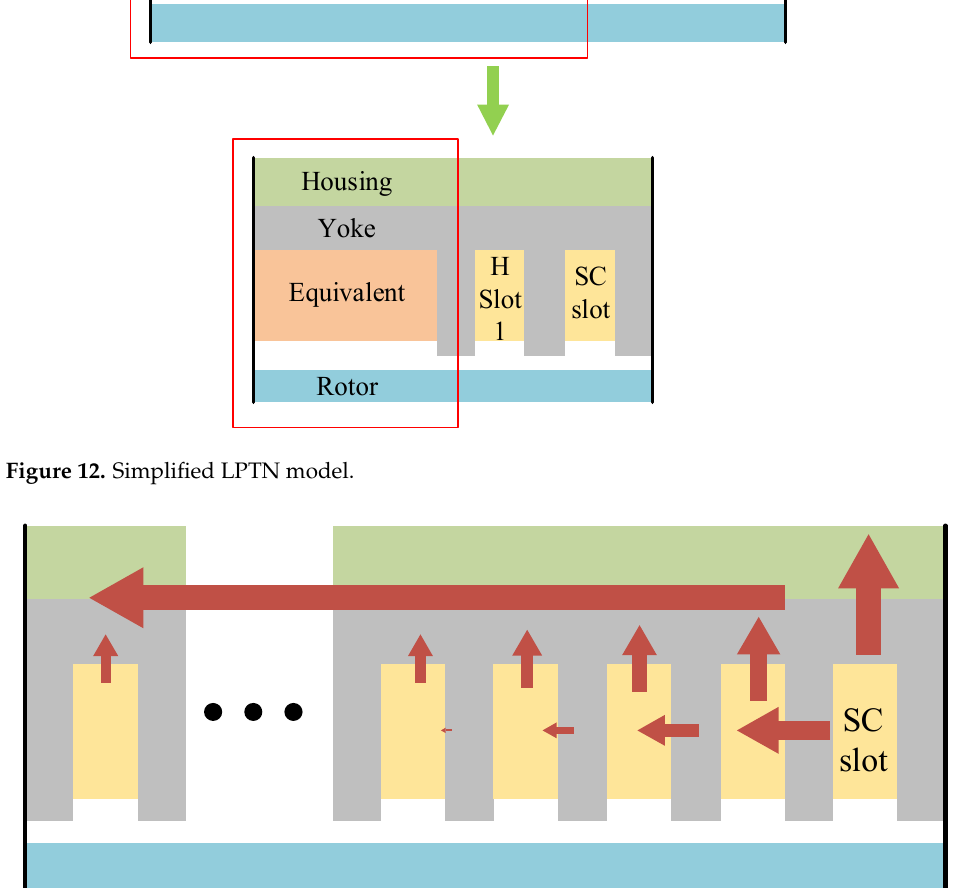
Figure 13. Heat transfer